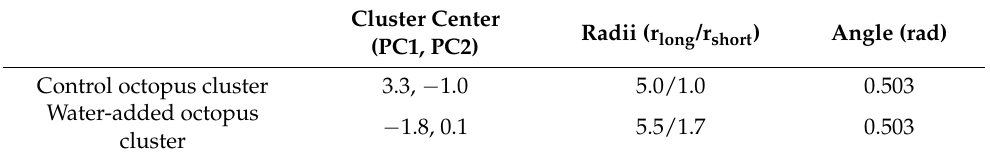
Table 3. Parameters of clusters determined for the calibration of TDR equipment to classify Octopus vulgaris as control or water added. PC1 and PC2 were the first two principal components obtained, and together explained 99.5% of the variation of the original